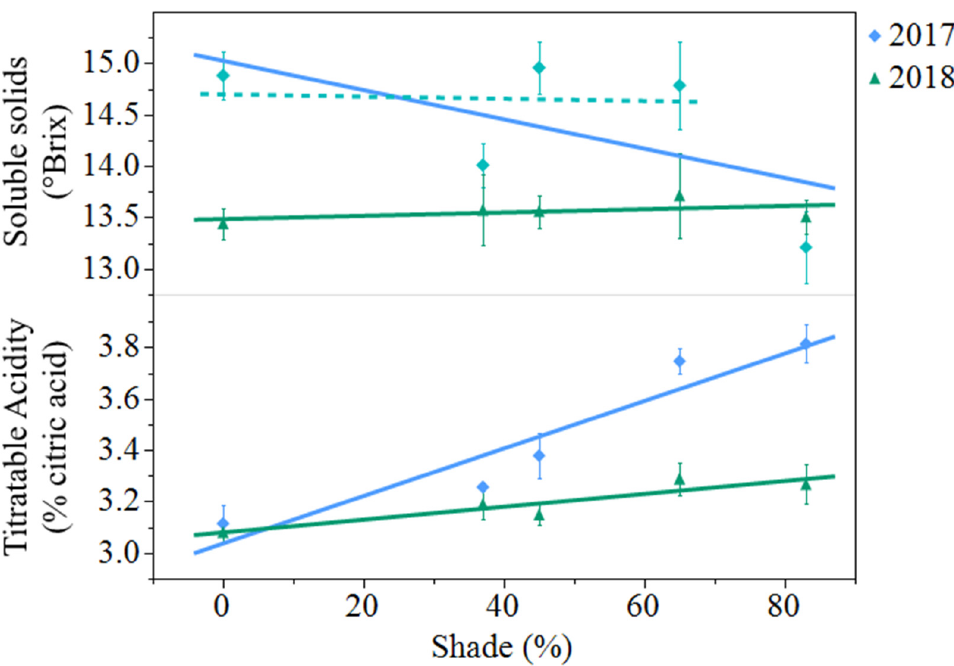
Figure 2. Artificial shade treatment effects on soluble solids and titratable acidity in juice of black currants ( Ribes nigrum c.v ‘Consort’) harvested in Urbana, IL in 2017 and 2018. Data are presented as the mean ± standard error of n = 4 replicates. Regression equations (where x = percent shade) were as follows: soluble solids (2017) = 15.0 − 0.0143x, r 2 = 0.22, p value = 0.0386; soluble solids (2017) regression without 83% shade treatment included in the model was not significant p value = 0.8852. Soluble solids (2018) = 13.5 + 0.0016x, r 2 = 0.01, p value = 0.6961; titratable acidity (2017) = 3.04 + 0.0092x, r 2 = 0.77, p value < 0.0001; titratable acidity (2018) = 3.08 + 0.0025x, r 2 = 0.31, p value = 0.0101.